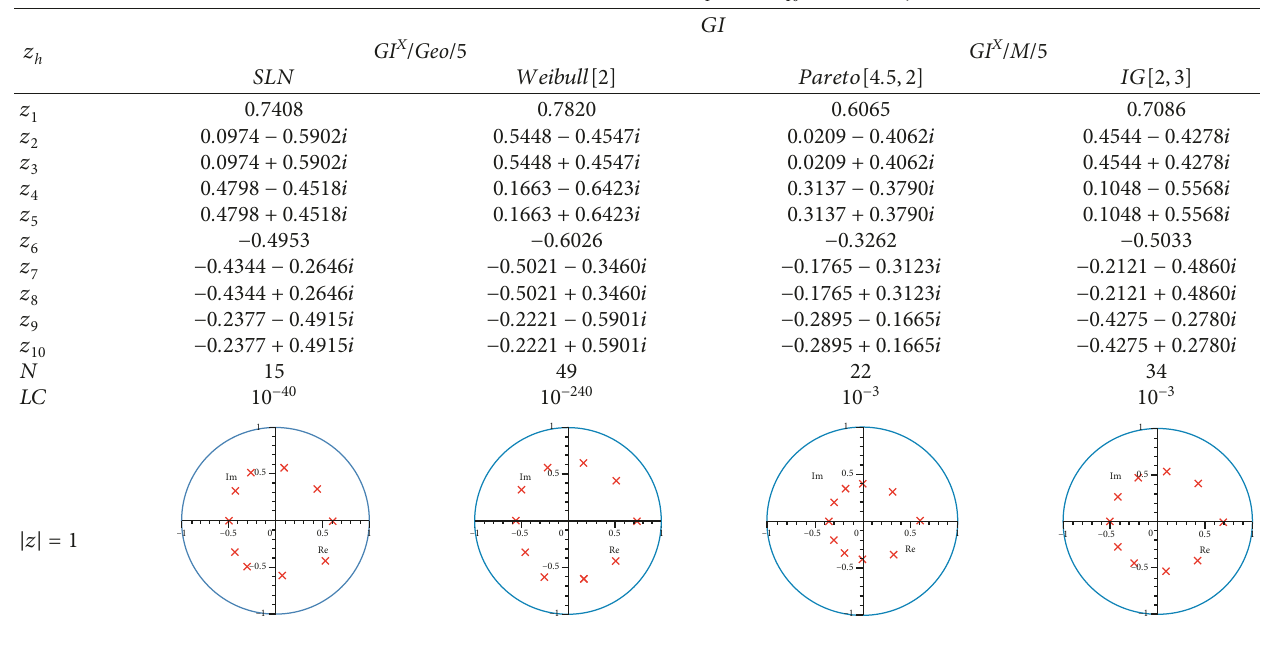
Table 3: (1,10) batch size distribution with b